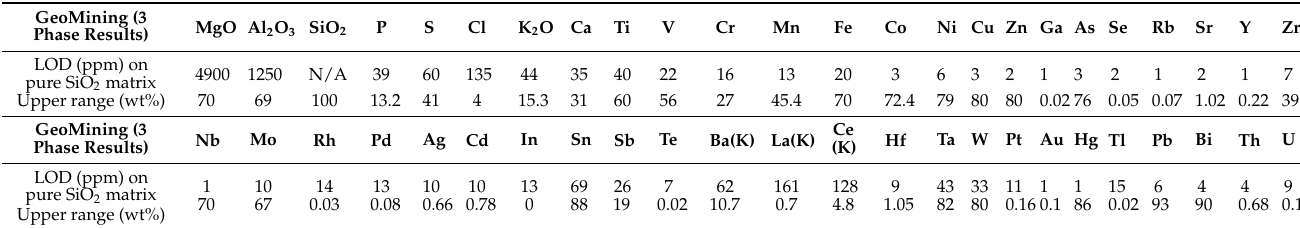
Table 1. Bruker S1 Titan. GeoMining Calibration (P/N: 730.0203). Sample prep: All calibration samples were prepared as dry sample powders packed into a sample cup and measured through a 4 micron foil. Limit of detection (LOD) specified for SiO 2 matrix in three sigma 99.7% confidence level and 180 s analysis time in 3-phase mode (60 s per phase). Calibration range: This is based on available reference materials and can be extrapolated up to 10% (relative) over the highest value. The calibration for Ba, La, and Ce was made using K-alpha and K-beta lines, and the other elements were calibrated using the K and L lines (Bruker 2017).